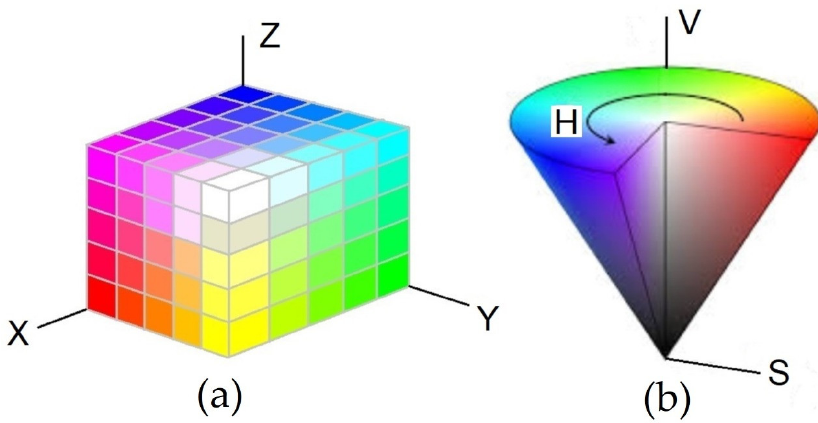
Figure 2. Color models: ( a ) RGB model; ( b ) HSV model.